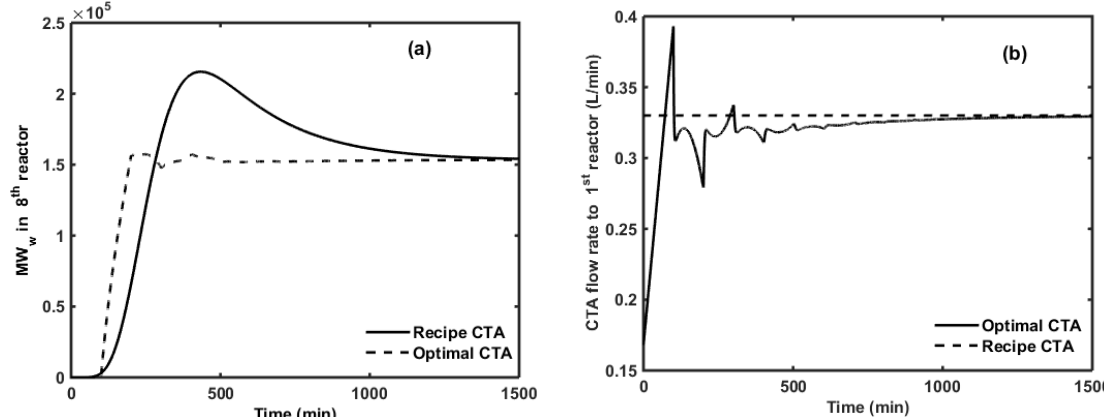
Figure 8. ( a ) Comparison of MW w profiles in the eighth reactor using regular CTA flow rate to that of using optimal flow rate of CTA; and ( b ) the dynamic CTA flow rate obtained from optimisation.